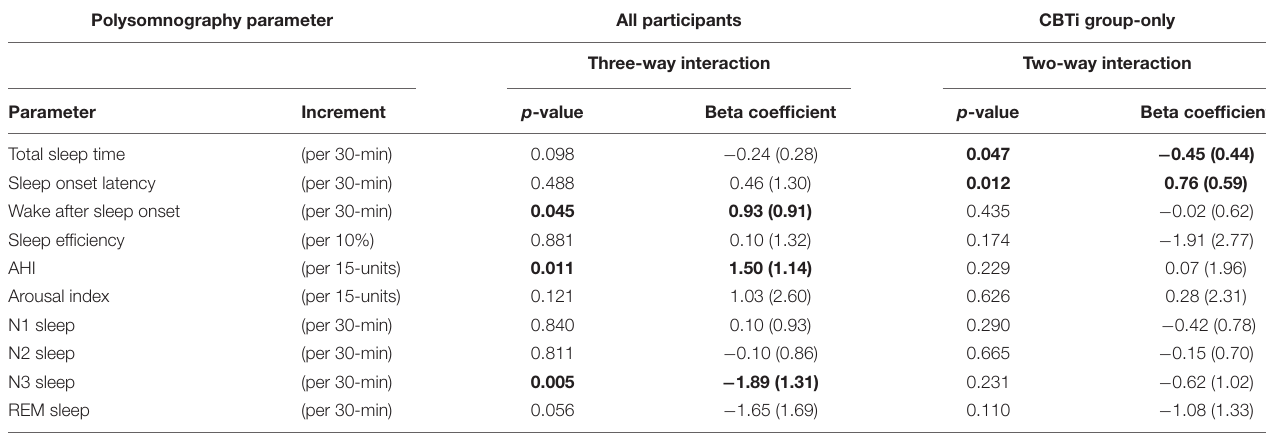
TABLE 2 | Effect of continuous polysomnography parameters on ISI change during CBTi, versus control, represented as beta coefficient ( ± 95% CI ). Polysomnography parameter All participants CBTi group-only Three-way interaction